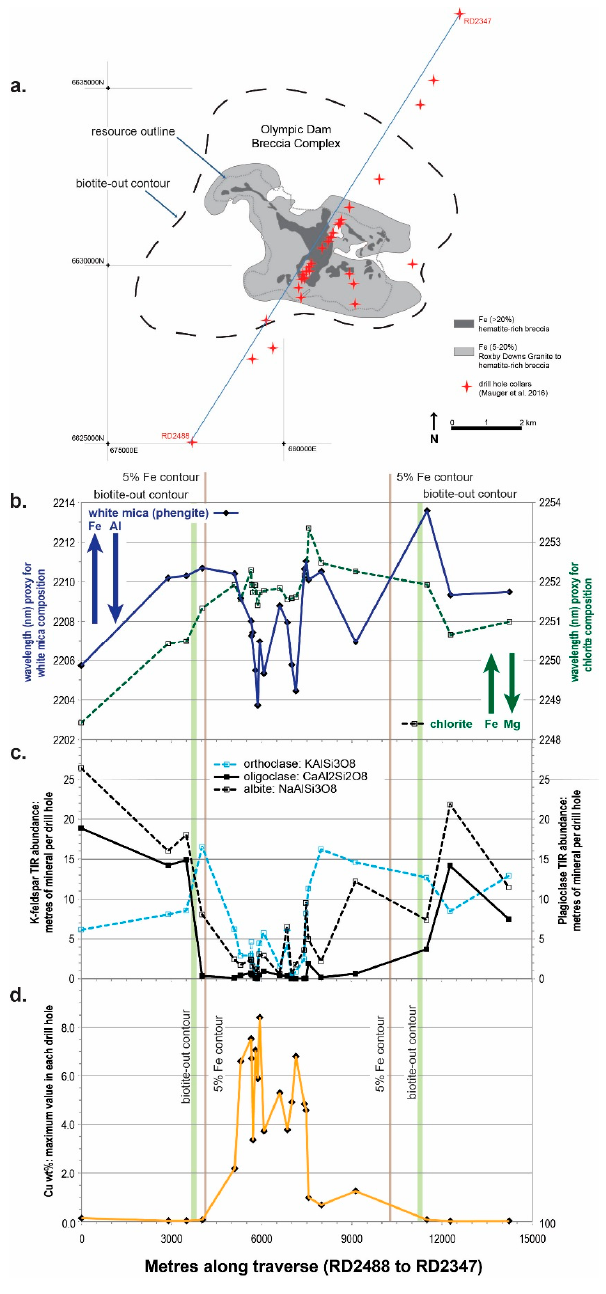
Figure 11. Summary of mineralogical trends across Olympic Dam. Modified from [20] and [27]. ( a ) Simplified outline of the Olympic Dam Breccia Complex within the Roxby Downs Granite showing the contour at which biotite is destroyed by progressive alteration (biotite-out contour), the 5 − 20% Fe zone and the >20% Fe zone. Also shown is the resource outline and drill holes analysed by HyloggerTM hyperspectral imaging [27]. ( b ) Cross section from drill hole RD2488 to RD2347 showing the wavelength of the characteristic absorption spectra from short-wave infrared imaging that characterizes white mica (phengite) and chlorite. Also indicated is the change in chemistry of the white mica and chlorite indicated by the changes in these absorption features. ( c ) Meters per drill hole of the K-feldspar and plagioclase abundance as measured by thermal infrared (TIR) imaging. Albite is greatest distal to the orebody, while orthoclase shows a slight increase towards the orebody. ( d ) Maximum values of Cu weight percent assays within each drill hole. The centre of the orebody is defined by the highest Cu